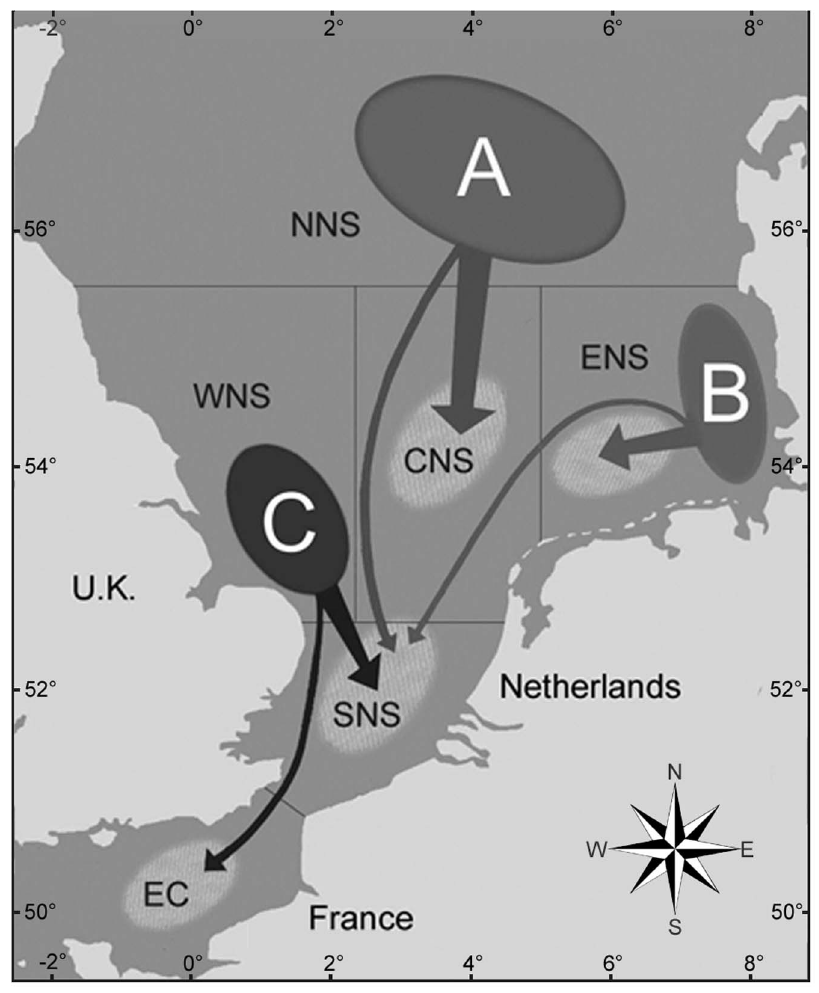
Figure 1. North Sea sub-stocks of plaice studied. The area covered by plaice migration between summer feeding aggregations (sub-stocks A, B, and C) and winter spawning grounds (light blue areas, [55]) was divided into 6 regions: the English Channel (EC: latitude , 51.00 u N), the Southern North Sea (SNS: latitude =51.00–52.49 u N), the Western North Sea (WNS: latitude =52.50–55.49 u N; longitude , 2.50 u E), the Central North Sea (CNS: latitude =52.50–55.49 u N; longitude =2.50–4.99 u E), the Eastern North Sea (ENS: latitude =52.50–55.49 u N; longitude $ 5.00 u E) and the Northern North Sea (NNS: latitude $ 55.50 u N). Arrows show principal migration routes for each sub-stock [45].